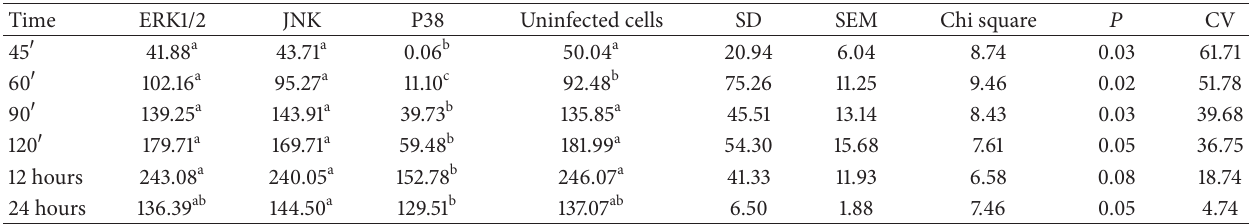
Figure 5: ERK phosphorylation.Detection of phosphorylation of ERK1/2 by Western blot in protein extracts of HEp-2 and A549 cells infected with HPIV-1 live at different time points: (a) phospho-ERK was detected with p-ERK1/2 (sc-81492) antibody as a loading control and total ERK1/2 (sc-292838) in HEp-2 cells; (b) densitometric analysis of ERK1/2 protein concentrations; (c) phospho-ERK and total ERK1/2 protein concentrations in A549 cells; (d) densitometric analysis of protein concentrations. Mp: molecular weight; CTL: control and UV (inactive virus) that corresponds to 12 hours in path 3. Data are the means for triplicate measurements from the three separate experiments. Table 2: IL-8 production (pg/mL) in infected HEp-2 cells treated with ERK1/2, JNK, and p38 kinase